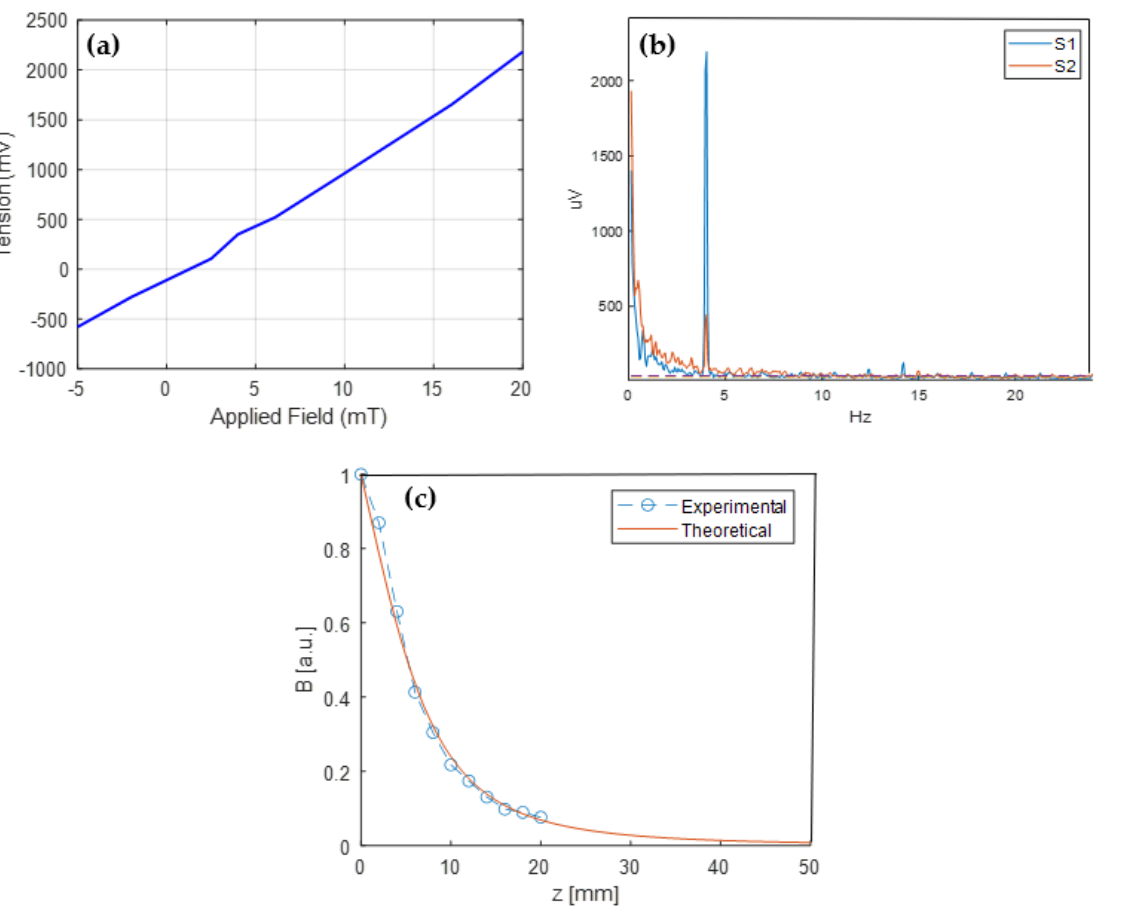
Figure 4. ( a ) Calibration curve of the AD-AD22151 Hall effect sensor obtained from the magnetometer built at PUC-Rio. ( b ) Noise graph of the AD-AD22151 Hall effect sensor, at the highest sensitivity S1 and the lowest sensitivity S2. ( c ) Graph that represents the dependence, theoretical and experimental, of the magnetic field of the magnet with the displacement in space in the z axis. Table 1. Magnetic field applied by the magnet Bz in Gauss in relation to the distance from the z axis in